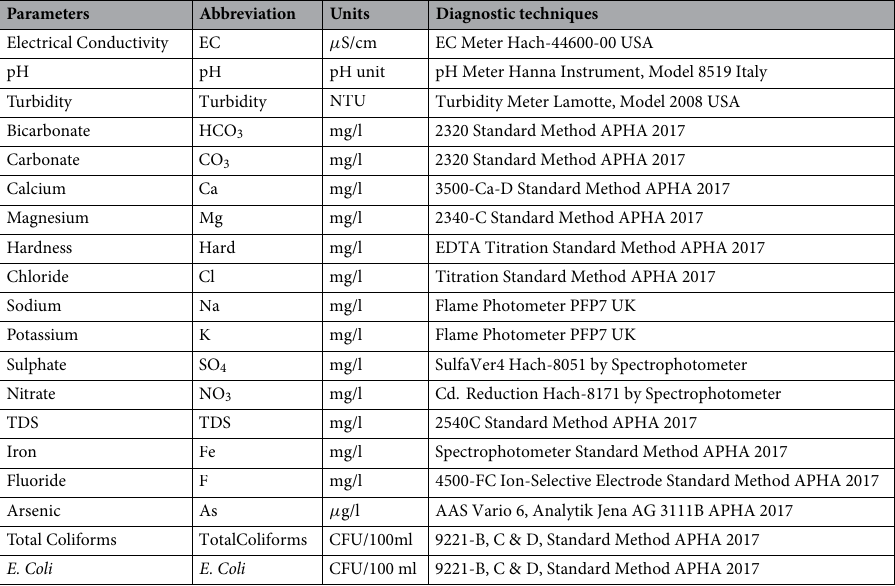
Table 1. Water parameters, their measuring units and diagnostic